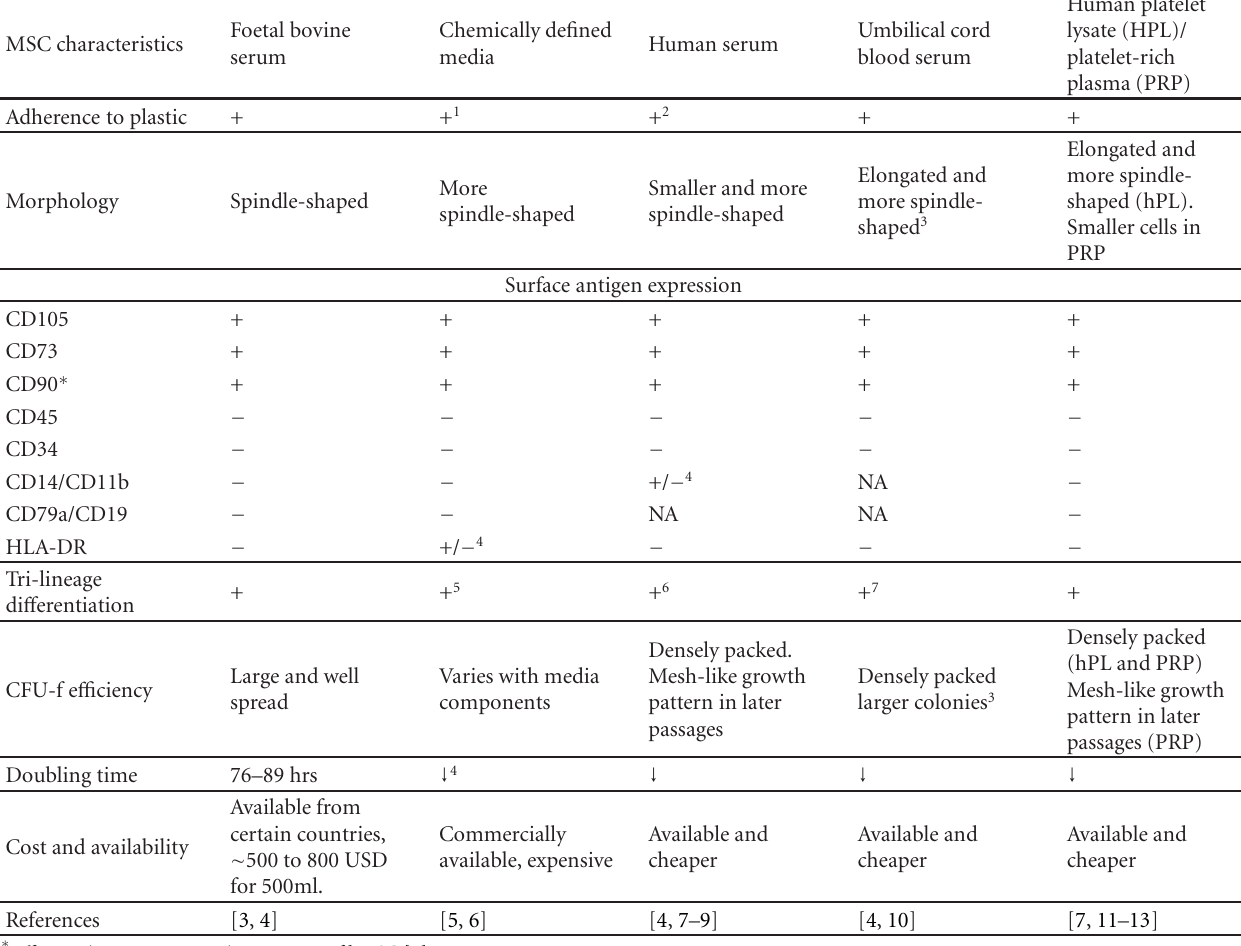
Table 1: Typical MSC characteristics (retention/loss) in various types of